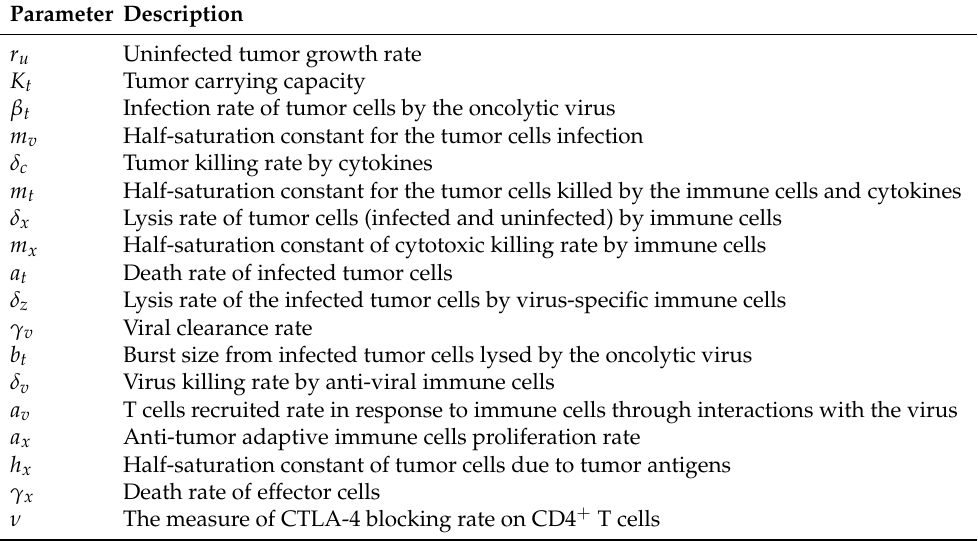
Table 2. Parameter